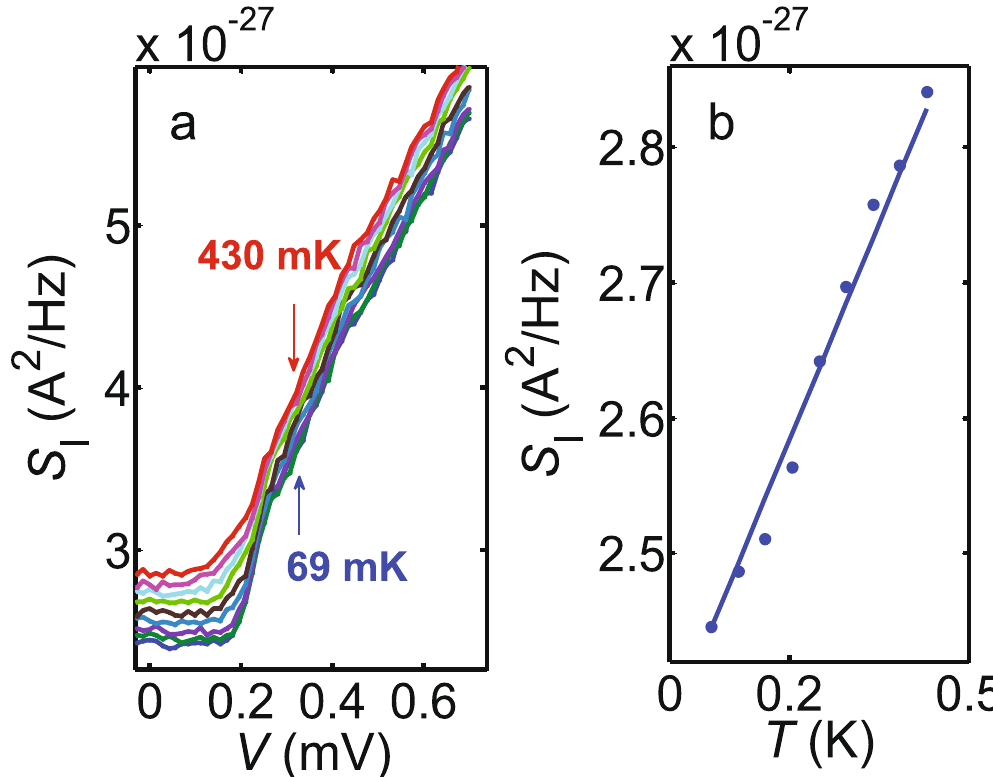
Figure 9. Temperature dependence of the total current noise. (a) , Bias dependence of the total noise S I at various values of the bath temperature at Φ ≈ 0.5 Φ 0 . (b) , Temperature dependence of S I at V = 0 and Φ ≈ 0.5 Φ 0 . As expected for thermal noise of R eff ( ≈ R at V = 0), the signal increases approximately linearly with slope 4 k B / R (solid blue line) with increasing T on top of a constant background ≈ . × − S 2 3 10 A /Hz